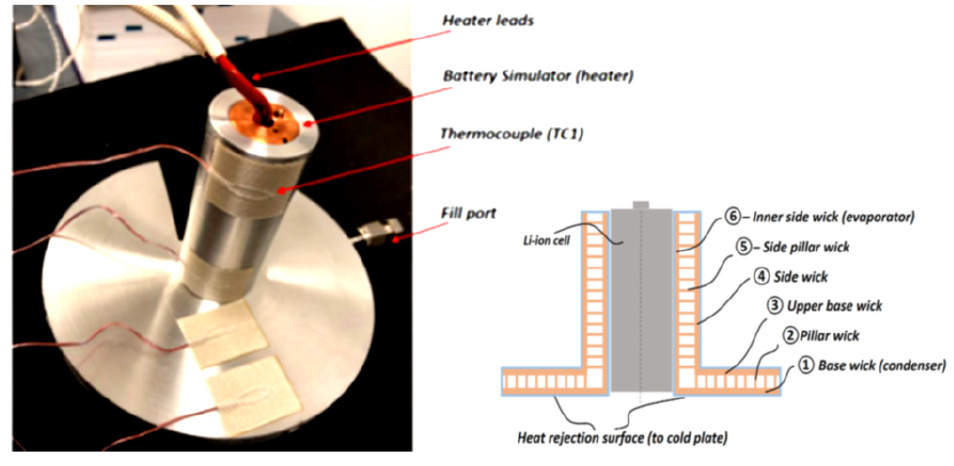
Figure 18. The unit cell battery case test setup ( left ) and a schematic ( right ) [18].